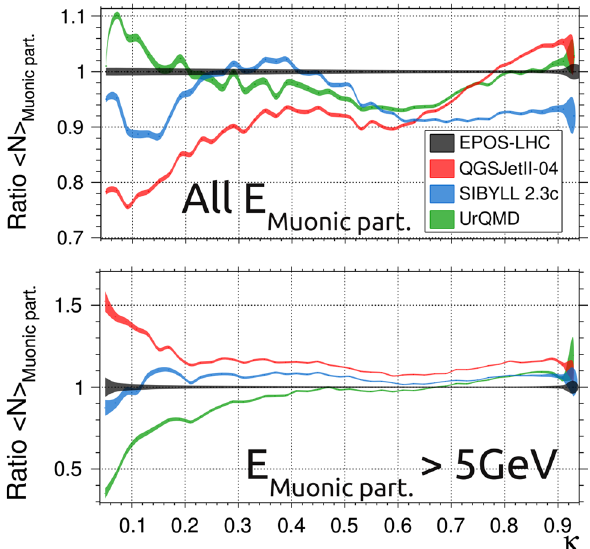
Fig. 6 Muonic family particle production ratios with respect to EPOS- LHC considering all particle energies (top panel) and above an energy threshold of 5 GeV (bottom